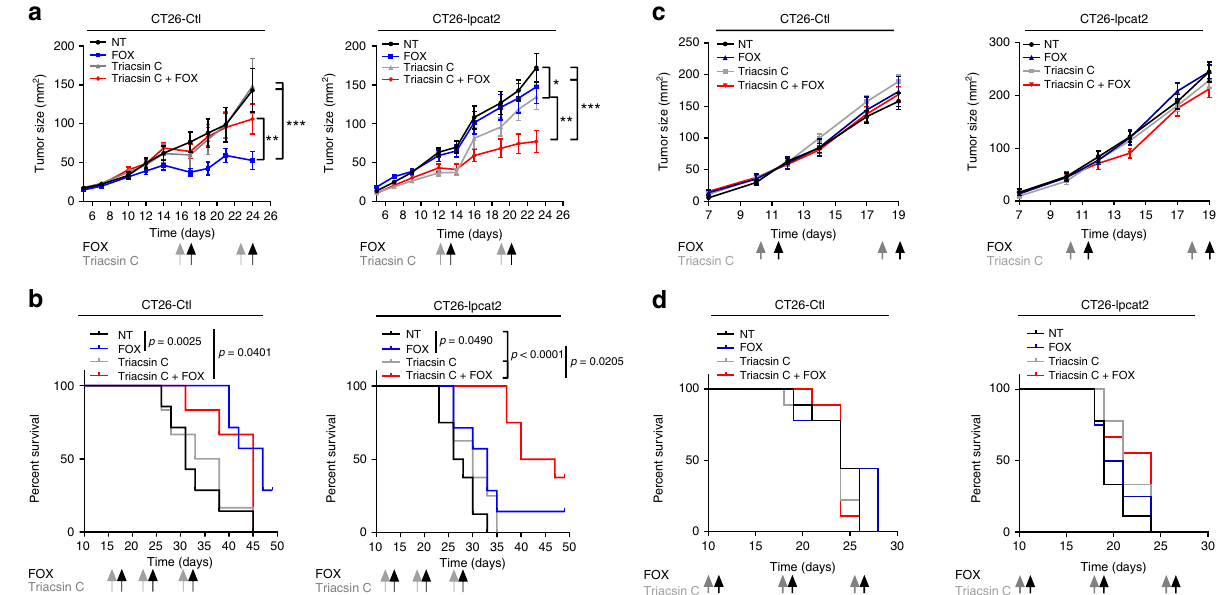
Fig. 8 Inhibition of LD production promotes tumour regression. a Twelve-week-old female balb/c mice ( n = 32) bearing CT26-Ctl or CT26-lpcat2 tumours were subdivided into four groups ( n = 8 per group) and intraperitoneally injected with triacsin C (2 mg/kg) once a week for 3 weeks followed the next day by FOX, or with FOX and triacsin C alone or with vehicles alone (NT groups). Tumour size in mm 2 over time is represented as median ± s.e.m. P values were determined by two-way ANOVA with Bonferroni correction. * p < 0.05, ** p < 0.01, *** p < 0.001. b Kaplan – Meier plots with time of death as endpoint for mice described in a are presented with p values assessed by a log-rank test. c Twelve-week-old female NMRI-nude mice ( n = 32) bearing CT26-Ctl (left panels) or CT26-lpcat2 (right panels) tumours were subdivided into four groups ( n = 8 per group) and treated as described in a . d Kaplan – Meier plots with time of death as endpoint for mice described in c are presented with p values assessed by the log-rank